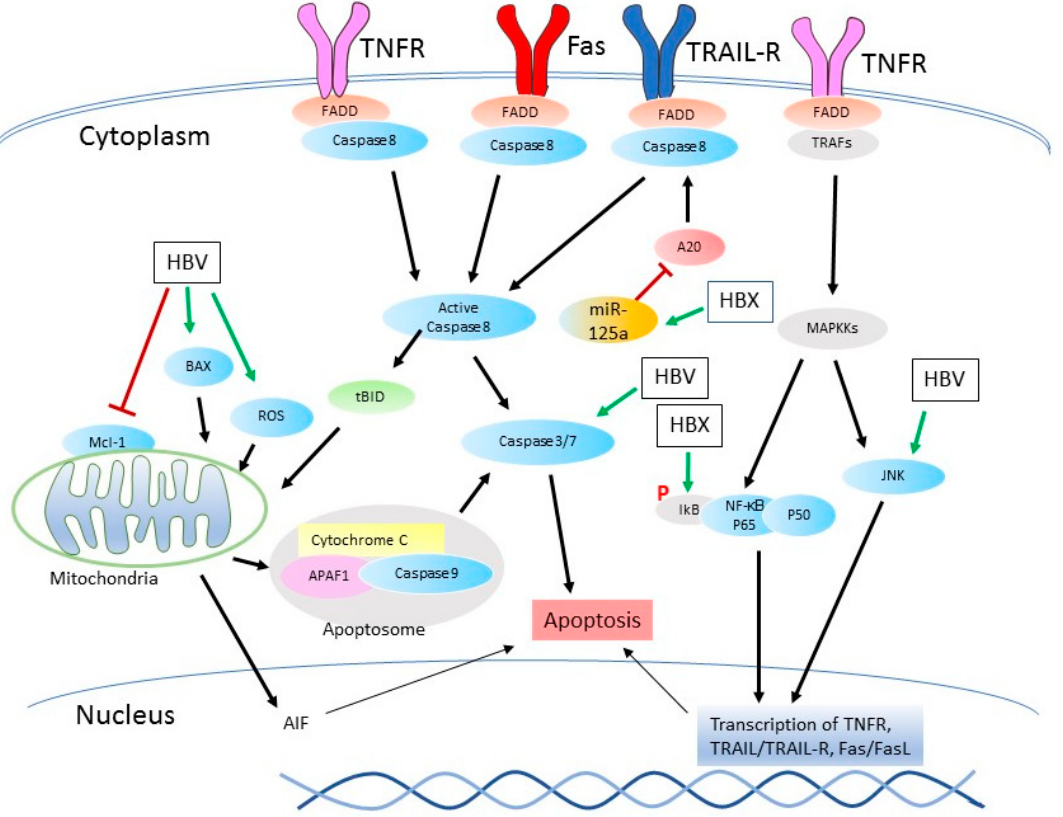
Figure 2. Pro-apoptotic role of HBV. HBV infection causes the activation of NF- κ B in hepatoma cells, and subsequent excessive expression of the death-associated receptors, which increase the cell sensitivity to stimuli. In addition, HBV directly induces the cleavage of caspase 3 to activate apoptosis. HBV induces the mitochondrial apoptotic signaling pathway by increasing the BAX expression and the ROS level or downregulating Mcl-1. The BCL-2 homology domain 3 (BH3)-like domain in HBX also plays a role in the induction of apoptosis. Green arrows mean the activation step of apoptosis; Red bars stand for the inhibition step of apoptosis.